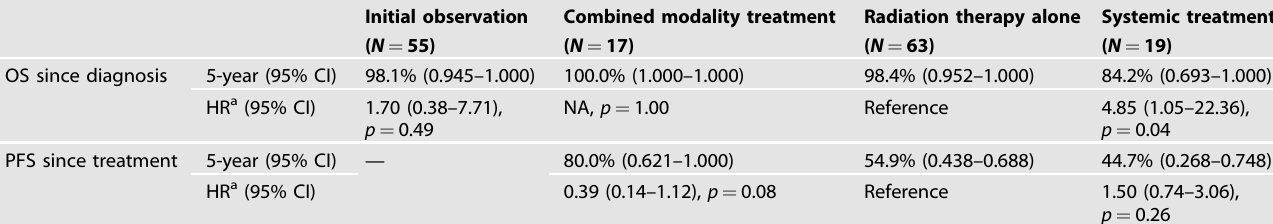
Table 4. Survival analysis in patients with stage I – II follicular lymphoma con fi rmed with positron emission tomography (PET) and bone marrow examination.